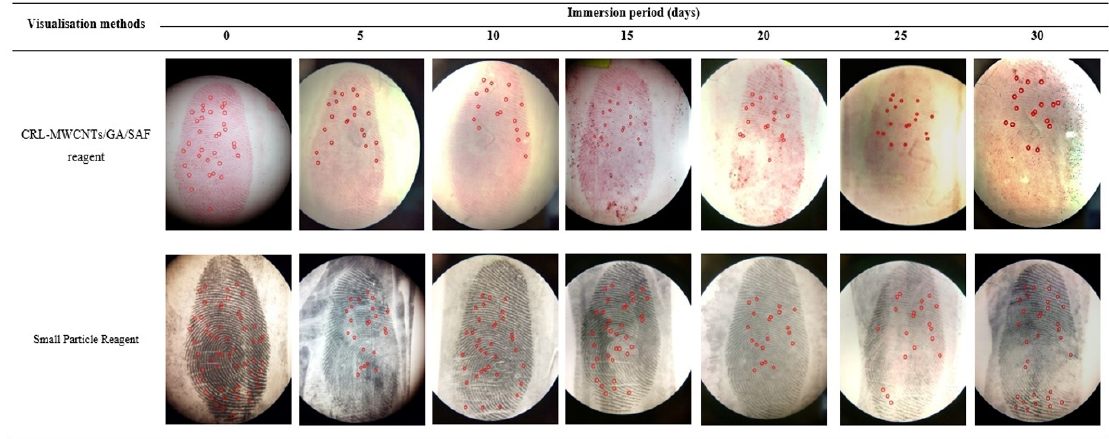
Figure 3. Visualized fingerprints on stainless steel knives immersed in a natural outdoor pond for specific immersion periods using the safranin-tinted CRL nanoconjugates reagent ( above ) and SPR ( below ) observed at 7.5 × magnification. The red dots represent the minutiae count of fingerprints for forensic identification purposes.